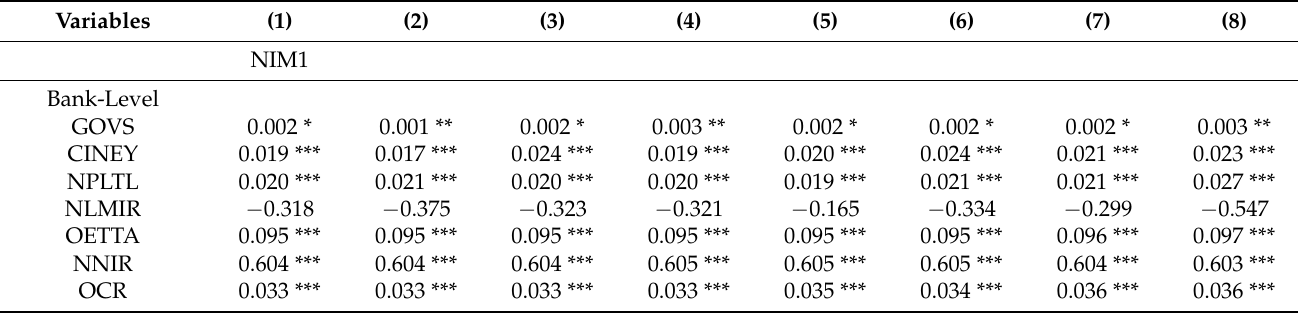
Table 11. Random effect